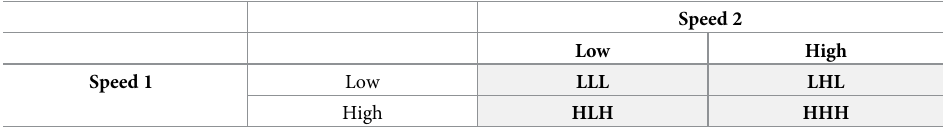
Fig 1. One can play the Auto Orbit video game by clicking on the following link: http:// andersonlab.net/orbit/signin.html. On this website, the low speed is referred to as the “slow”